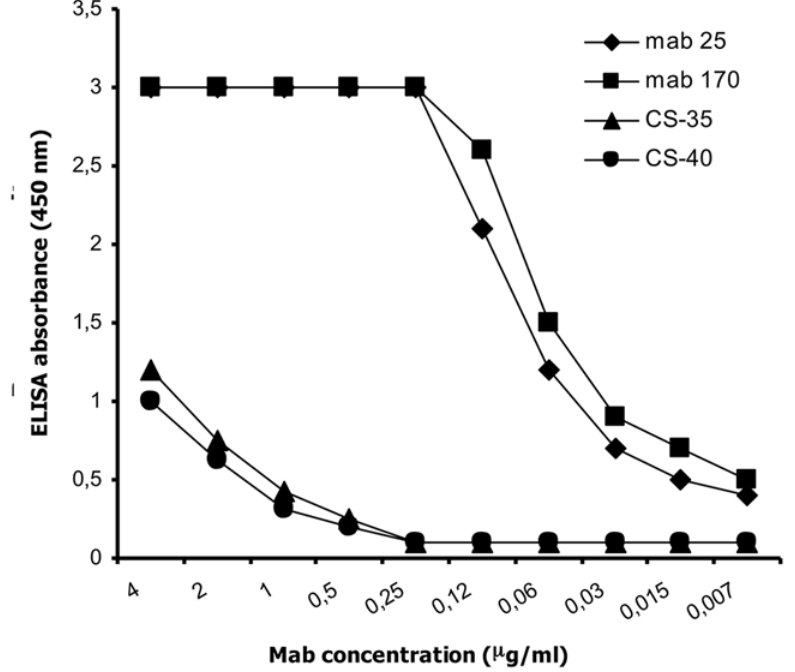
Fig 2. ELISA titration curve of inhouse Anti-LAM mAbs 25 and 170 compared to the reference anti- LAM mAbs CSU-35 and CSU-40.